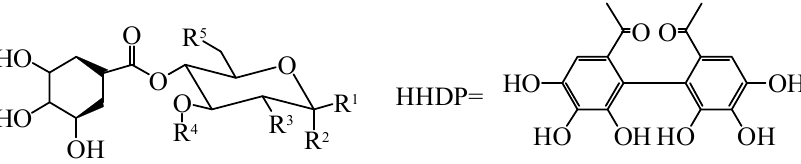
Figure 5. Chemical structures of others from Hippophae species. Molecules 2020 , 25 , x 3 of 28 Table 3. Others from Hippophae species.